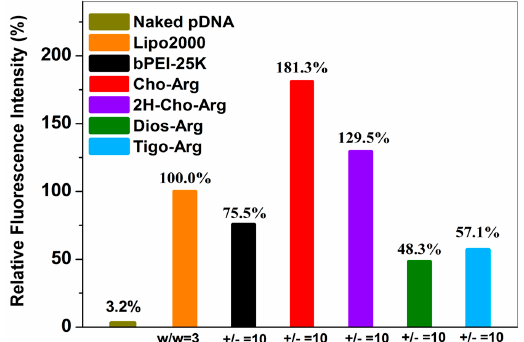
Figure 6. Intracellular uptake of the steroid-based cationic lipids/pDNA lipoplexes in HeLa cells analyzed by FACS. Lipo2000 and bPEI-25k were utilized as the controls for gene transfection in the optimized dose.